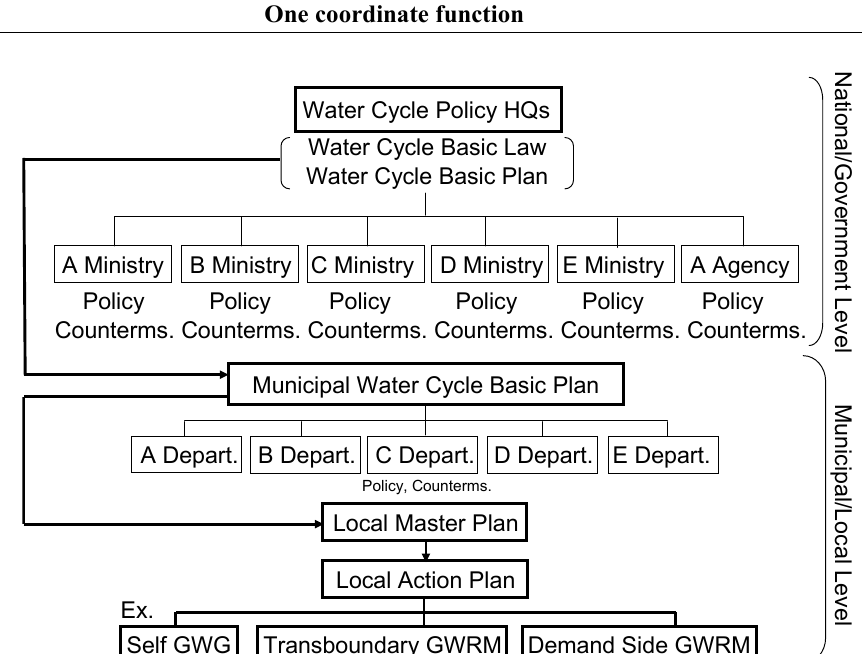
Fig. 3 Image of organizing structure corresponding to the Water Cycle Basic Law under planning in